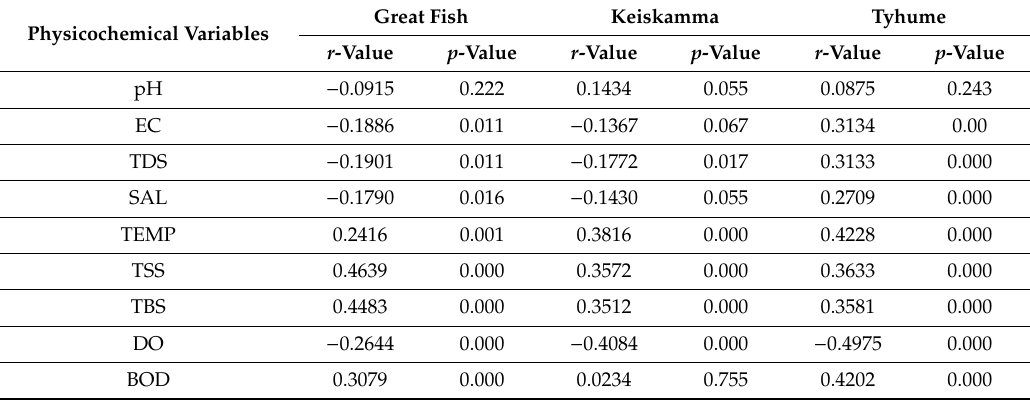
Table 3. Correlation between the density of presumptive Acinetobacter species and the physicochemical variables in the three rivers